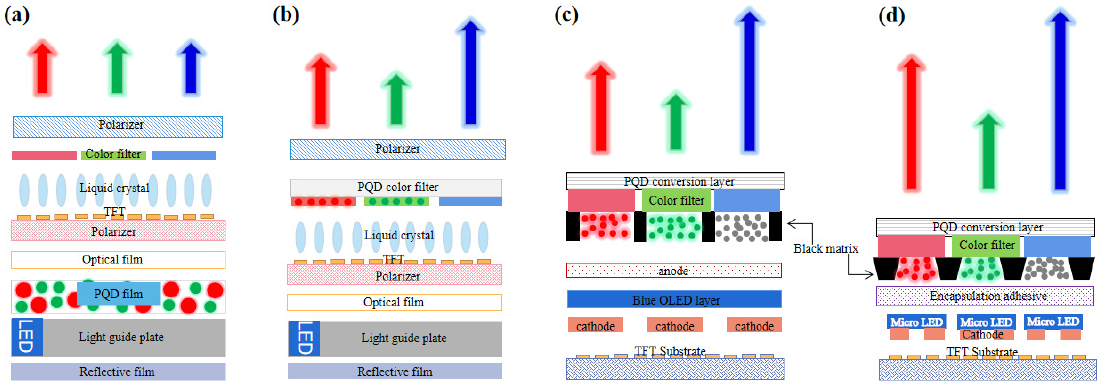
Figure 8. Photoluminescence display application of PQDs: ( a ) QD backlight; ( b ) QDCF; ( c ) full-color OLED with QDCCLs; ( d ) full-color micro-LED with QDCCLs.